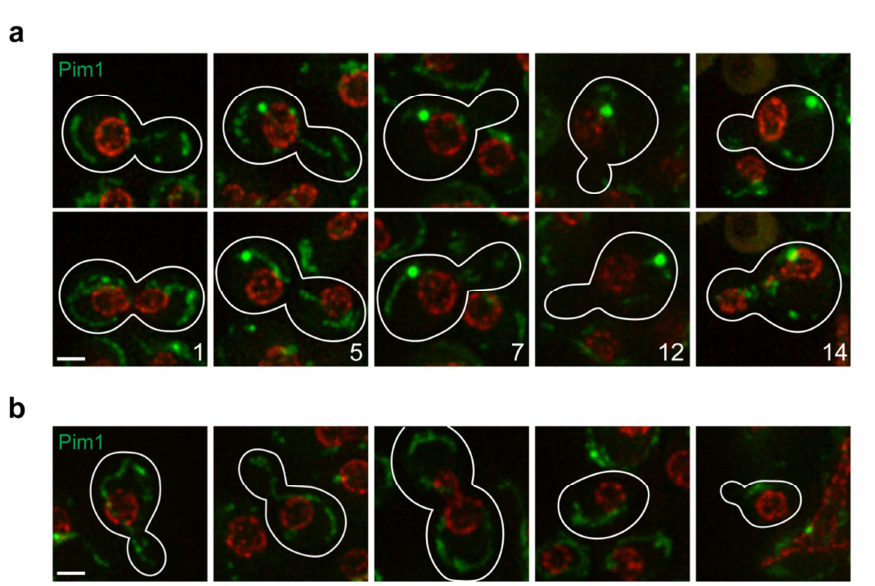
Figure 3: Pim1-GFP localization changes with age. Changes in protein localization were monitored in MEP cells expressing Pim1-GFP (a, b)